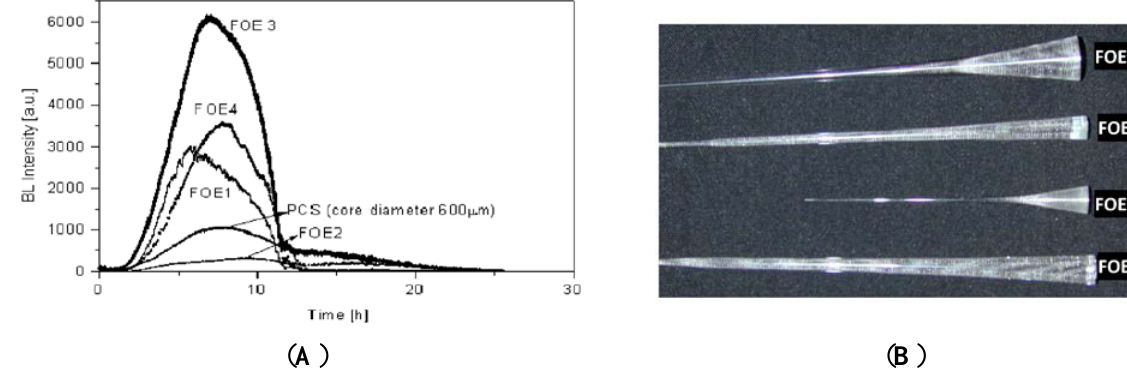
Figure 9. ( A ) Dependence of detected BL by FOE 1–4; ( B ) Photos of real samples of FOE produced at IPE